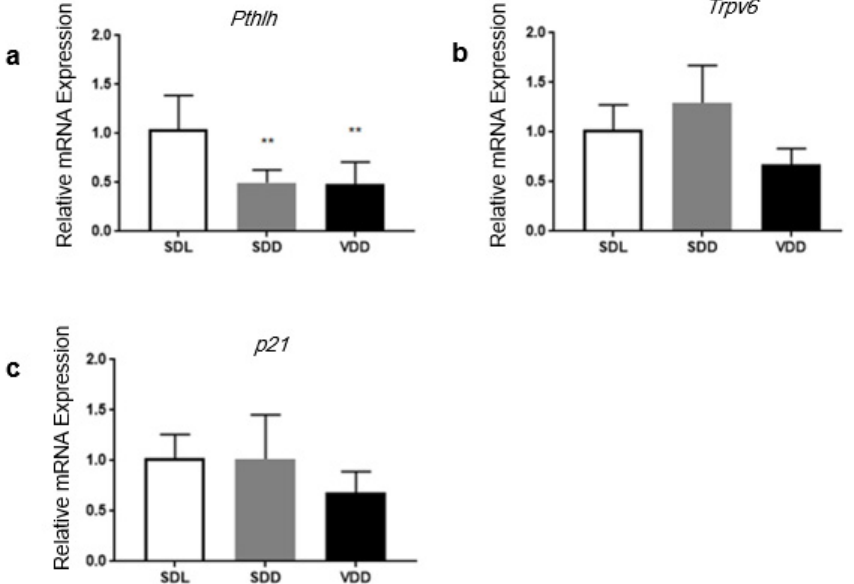
Figure 8. The expression of 1 α ,25(OH) 2 D 3 targeted genes. RNA was extracted from the corpora of approximately 4-month- old SDL, SDD and VDD mice ( n = 7/group) for the qPCR analysis. Relative mRNA expression of ( a ) Pthlh , ( b ) Trpv6 and ( c ) p21 all showed a decline in VD-deficient mice compared with the SDL controls. A one-way ANOVA was employed for the data analysis. ** p <